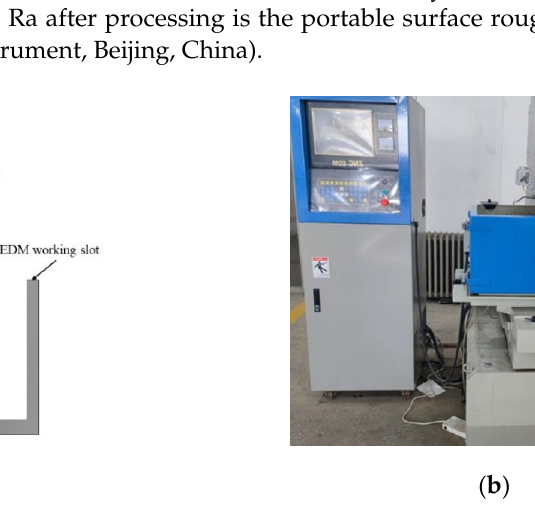
Figure 1. Schematic diagram of processing and experimental equipment; ( a ) schematic diagram of machining process; ( b ) EDM machine used in the experiment.